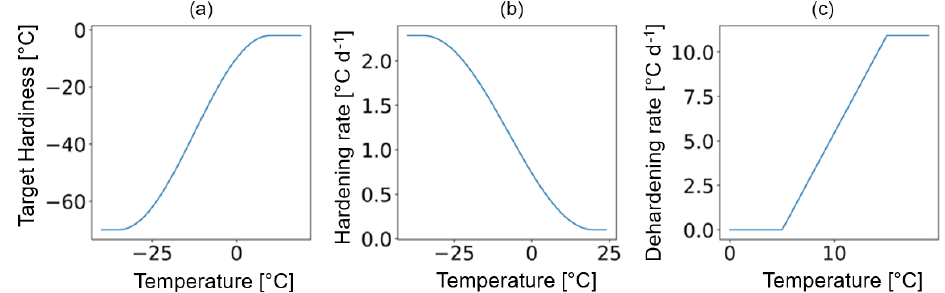
Figure 2. Example of (a) the target hardiness (TH), (b) the hardening rate (HR, in ◦ Cd − 1 ), and (c) the dehardening rate (DR) functions (in ◦ Cd − 1 ) in relation to the ambient mean temperature corresponding to a site and a plant functional type with a maximum hardiness level ( H MAX ) of − 70 ◦